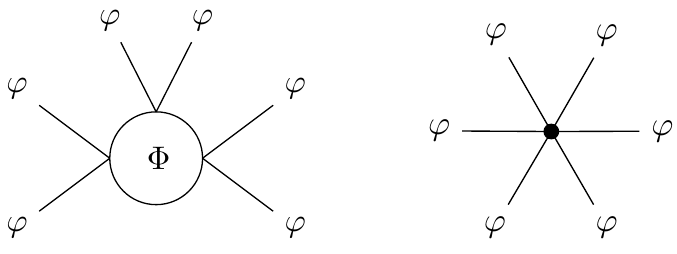
Figure 3 . Coupling of six light ϕ -particles with a heavy Φ -excitation running in the loop (left) and its corresponding six-point vertex in the EFT (right). The EFT vertex will be suppressed by the mass scale of the heavy degree of